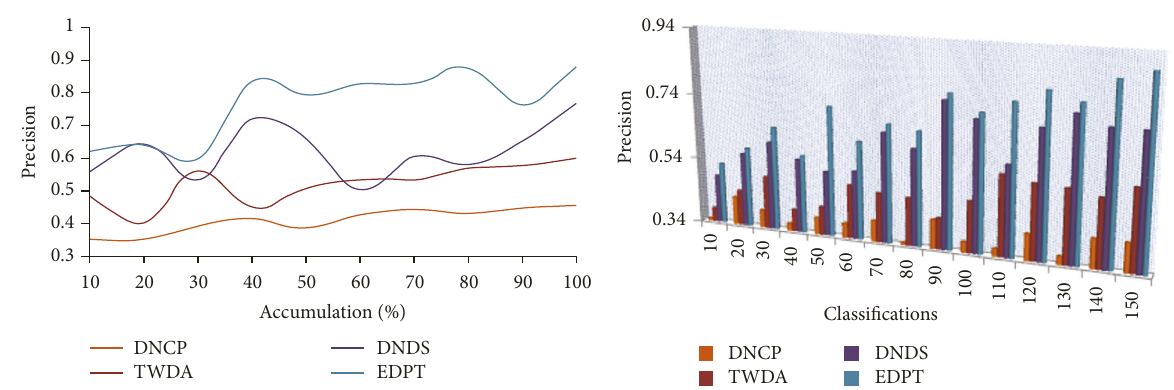
Figure 8: Precision.